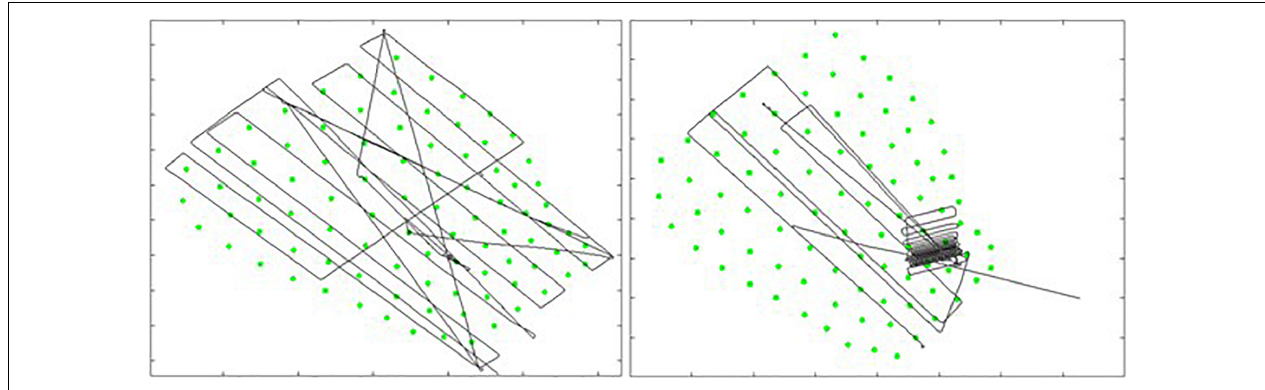
FIGURE 2 | Track lines from the 2017 (left) and 2019 (right) MBES surveys. 1 (Reproduced from Kates Varghese et al. (2020) with the permission of the Acoustical Society of